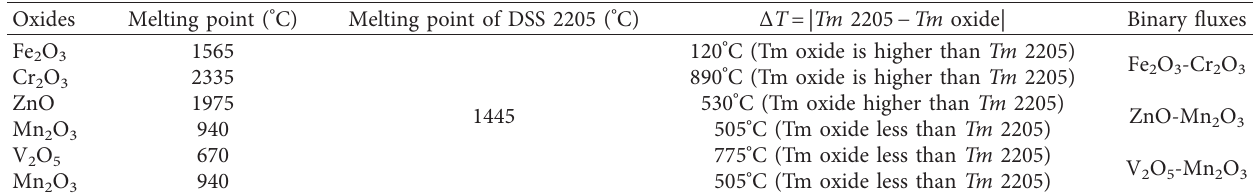
Table 4: Comparison between melting temperature of oxides and duplex stainless steel.